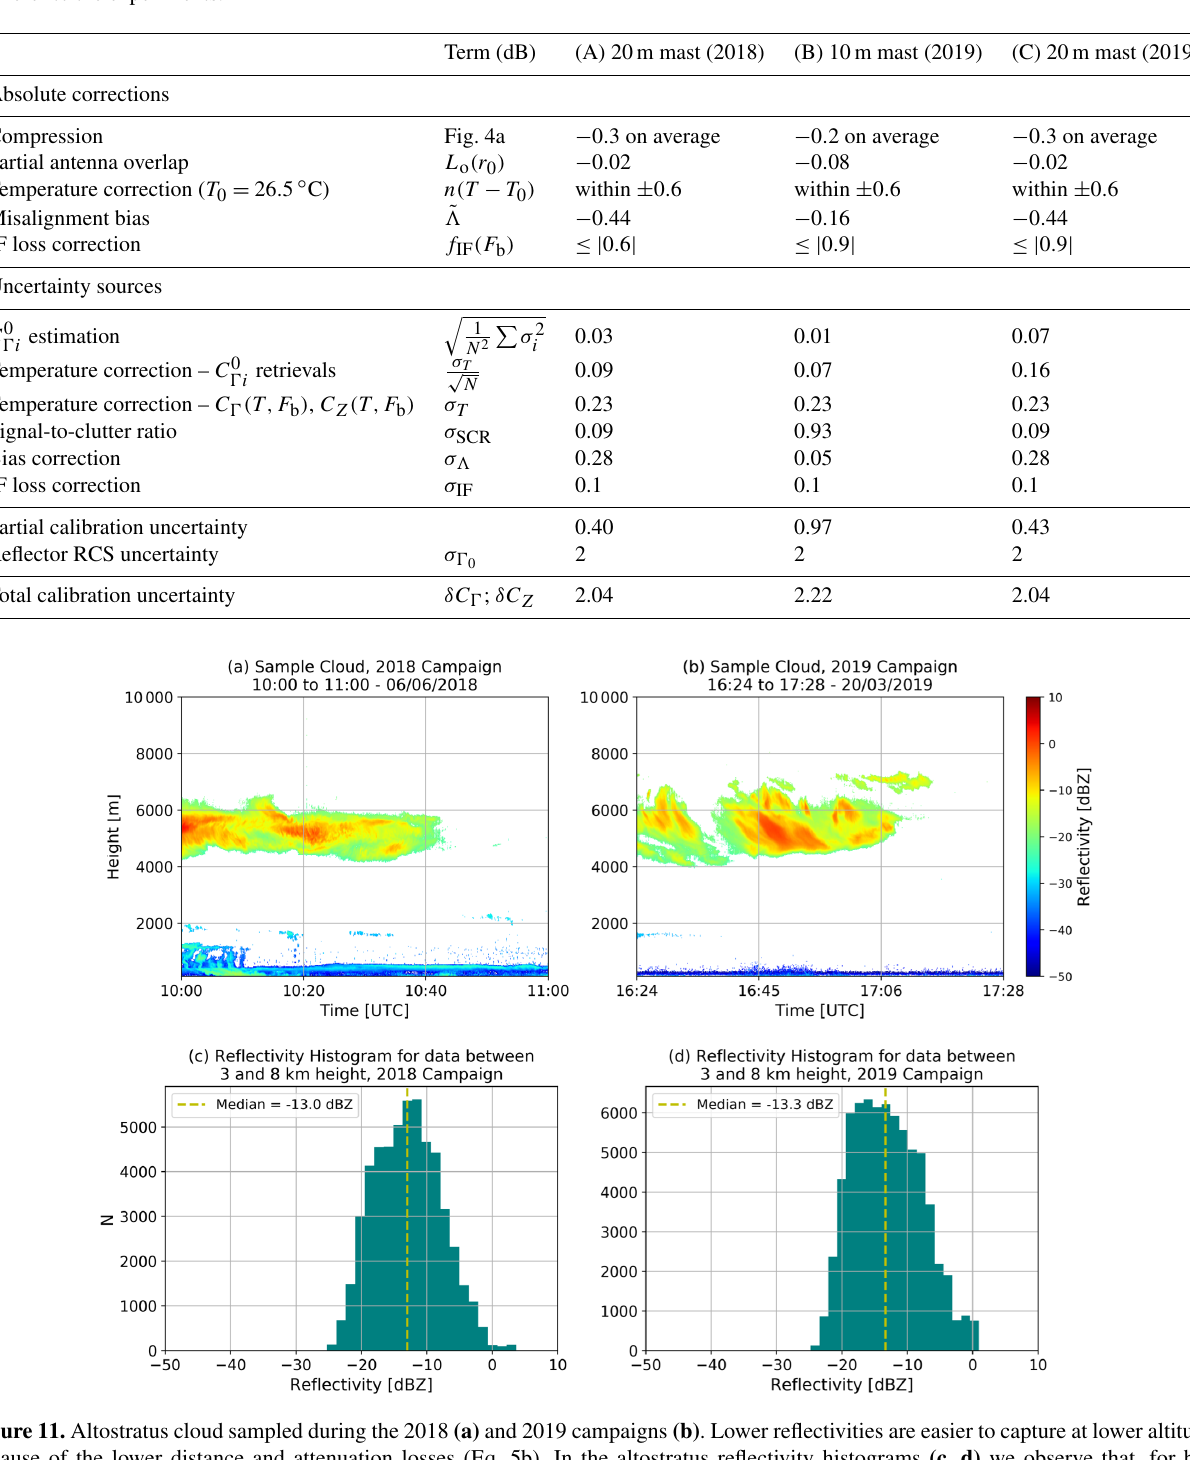
Table 2. Summary of all known corrections and uncertainty contributions in the calculation of C (cid:48) (T,F b ) . The absolute correction terms have a sign associated with the direction in which they impact the final calibration calculation. For the receiver compression correction, we present the average magnitude, and for the temperature correction, we present the range of possible values. The partial calibration uncertainty is the addition of all uncertainty terms except σ (cid:48) . This term is later added to calculate the total calibration uncertainty. Note: (A), (B) and 0 (C) refer to the experiments.